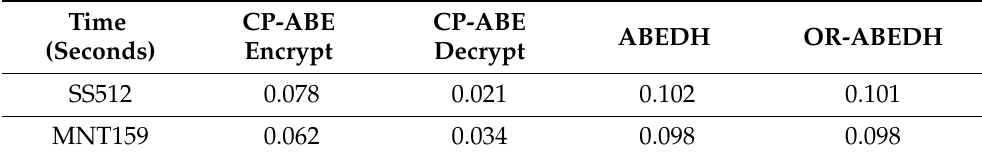
Table 2. Computation time tested for the proposed authentication protocols and the underlying CP-ABE scheme.